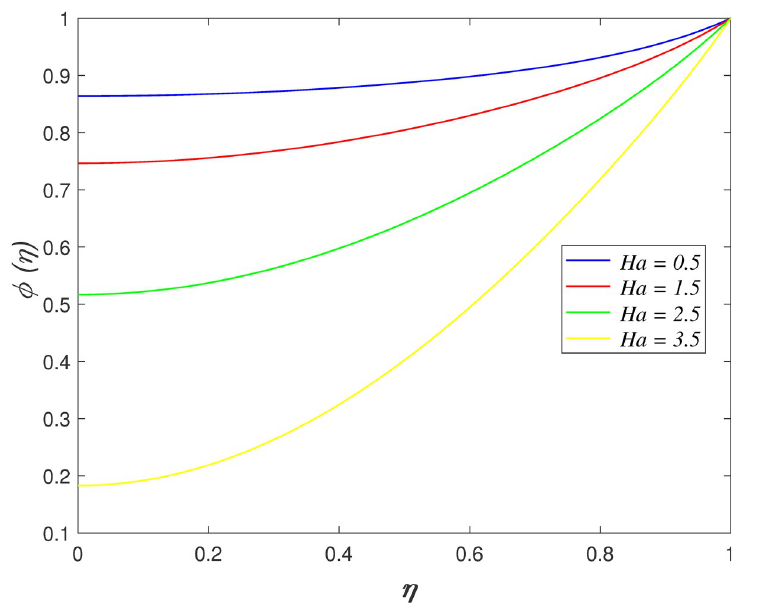
Fig 13. Impact of Ha on concentration.